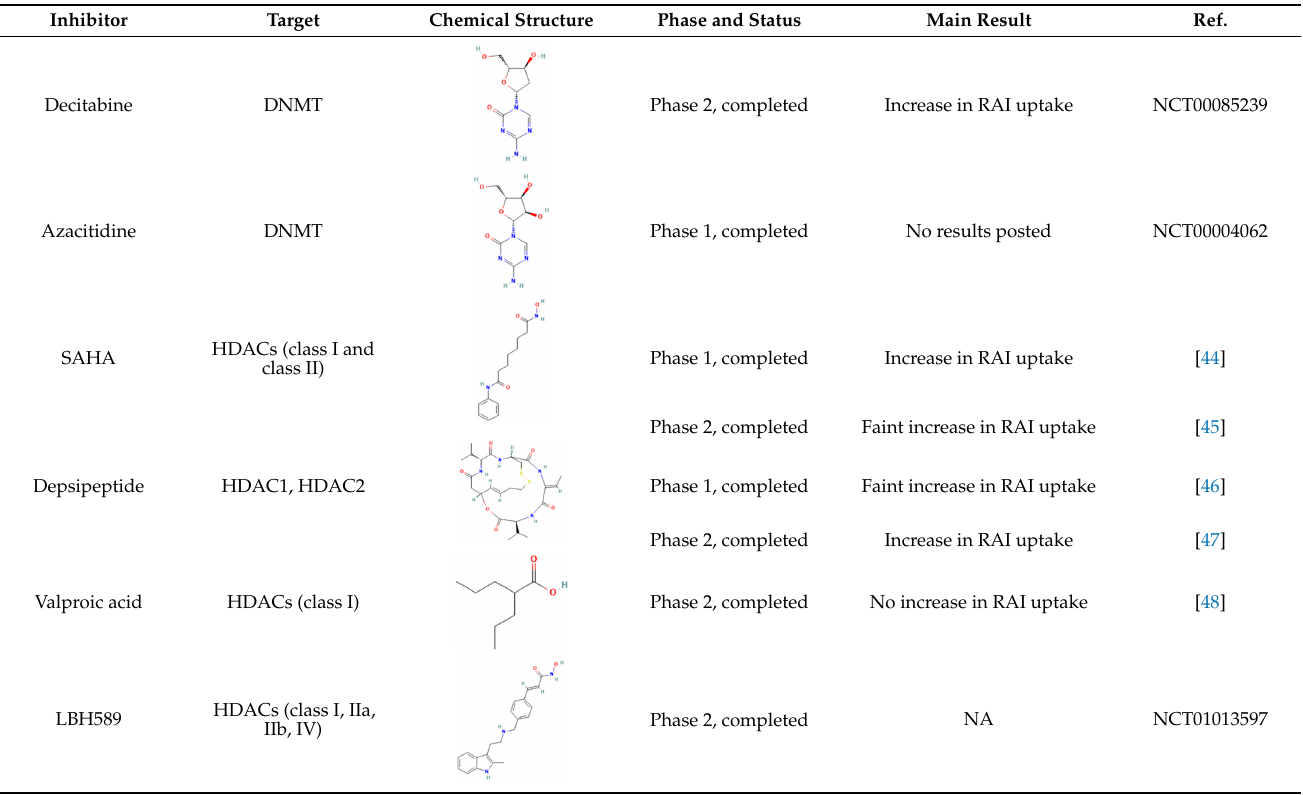
Table 2. Clinical data on epigenetic inhibitors in thyroid cancer treatment.